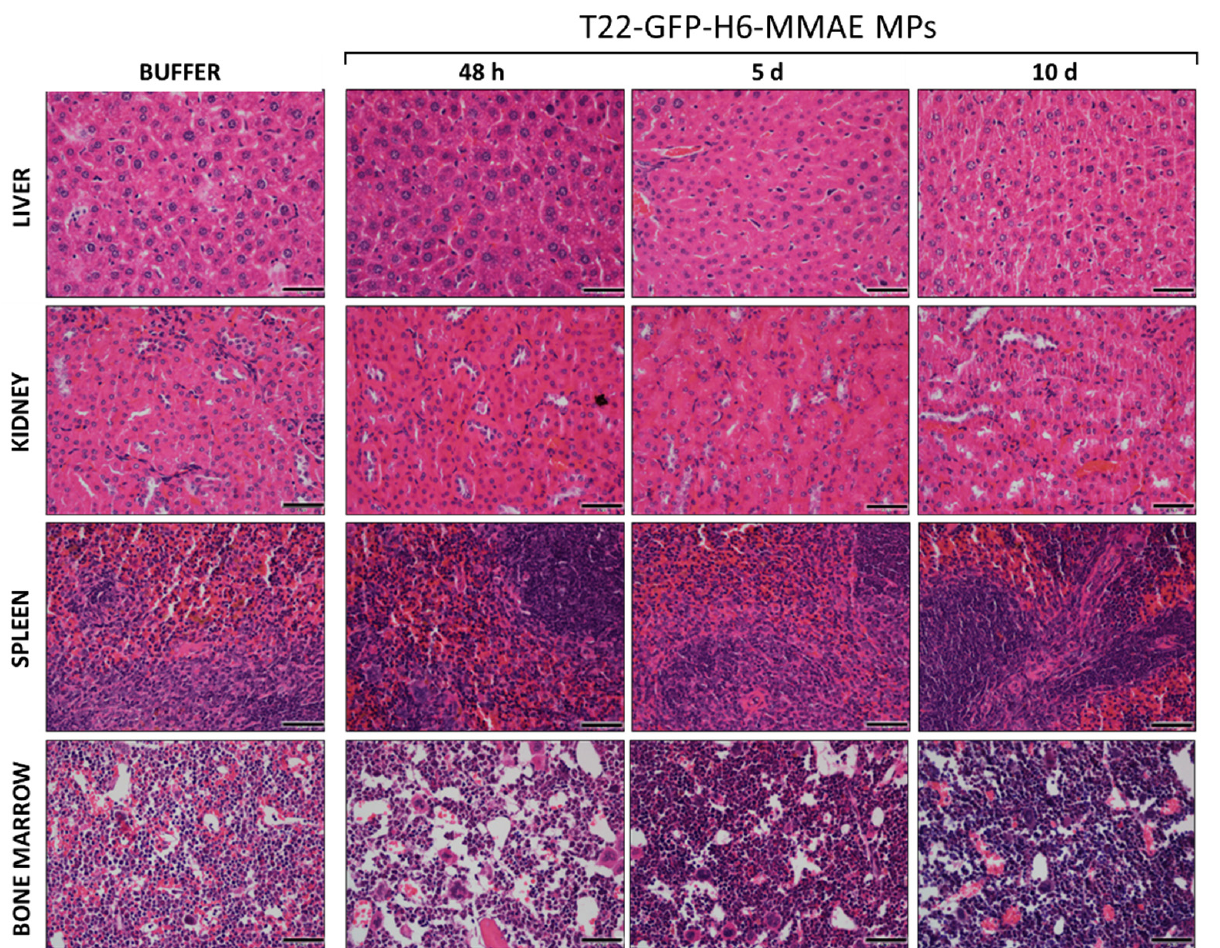
Figure 4. In vivo biodistribution and antitumoral effect of subcutaneously administered protein ‐ MMAE depots in a SC mouse model of CXCR4 + DLBCL − cells. ( A ). Ex vivo fluorescence imaging